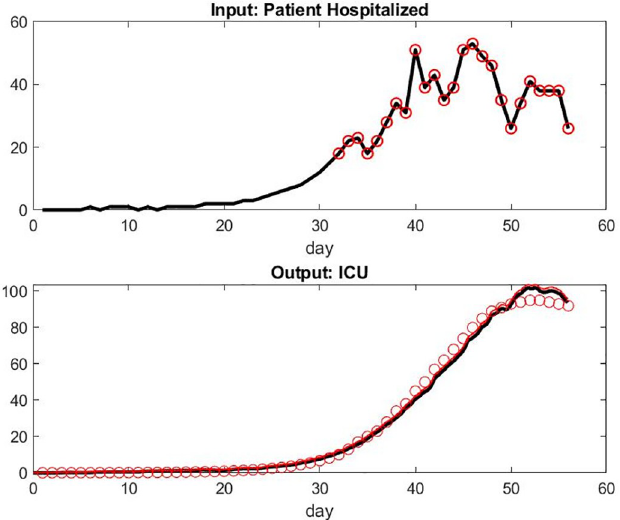
Fig 4. Model compared with data from France hospitals. Day 32 corresponds to March 18, 2020: the first date of our data set. We assume an exponential model for the period anterior to this date. Day 52 corresponds to April 11, 2020. Top: Input of patient hospital admission. Bottom: model of patient under mechanical ventilation in ICU versus the data set.